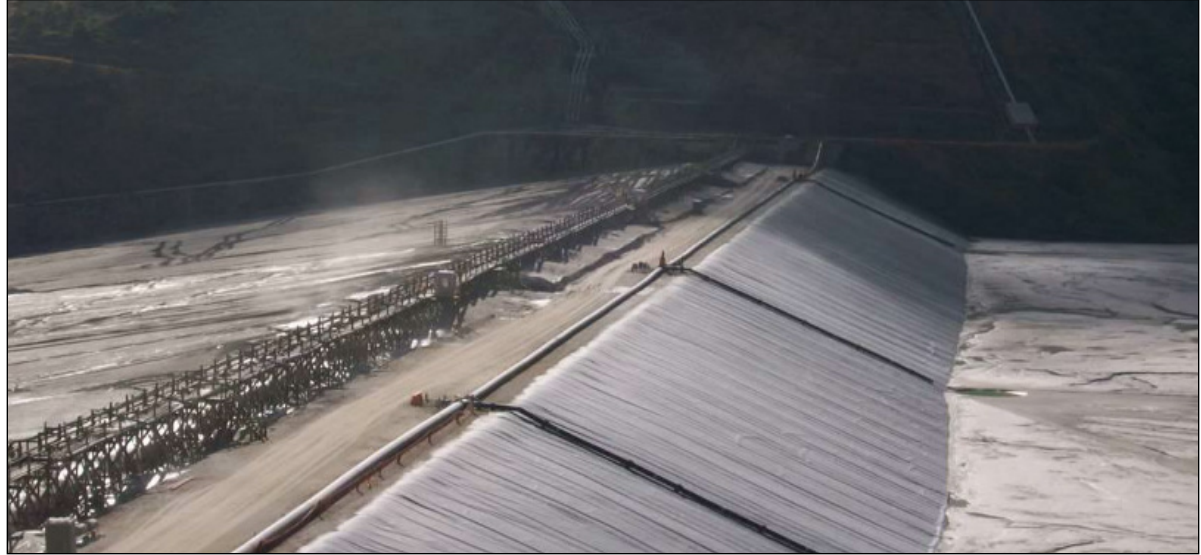
Figure 20. Cycloned tailings sand dam upstream face waterproofing—TSF, Chile [44].